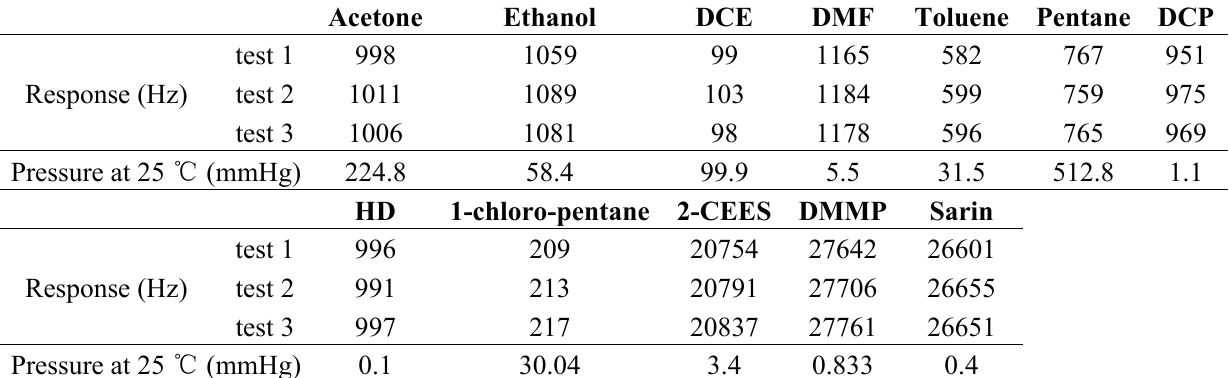
Table 1. Sensor responses to various vapors at 10 mg/m 3 .